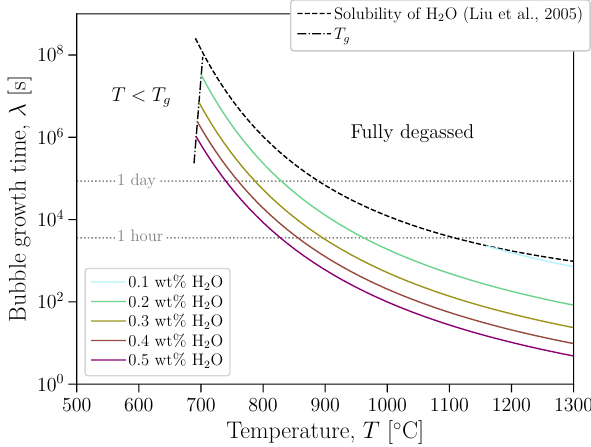
Figure 6: Guide for makers. A quantitative map show- ing how long obsidian should be held at a given tem- perature in order to ensure that all the residual water in the obsidian is removed during the growth of bub- bles. The individual curves are given as examples and represent solutions to the numerical model for bubble growth in obsidian provided by Coumans et al. [2020] for five different typical dissolved water concentrations in the range 0.1–0.5 wt.%. The field T < T —demarked g by the dash-dot curve—represents temperatures below which obsidian will never soften. The dashed curve rep- resents the interconnection of the output value of λ for the temperature at which the initial H O value is at the 2 solubility of H O, meaning that at any temperature be- 2 low that value, bubbles will not form or grow. For ex- ample, see 0.1 wt.% H O which terminates against the 2 dashed curve at around 1150 °C, such that the blue curve is only valid at temperatures greater than 1150 °C. There- fore, for obsidian with 0.1 wt.% H O initially, at tempera- 2 tures lower than 1150 °C, the obsidian can be used with- out this pre-processing step. To define the dashed line for a more closely spaced number of values of initial H O concentrations than given as solid curves here (to 2 define the dashed curve, we use 0.05–0.2 wt.% closely spaced). The dashed curve also shows that this limit is not relevant for initial H O concentrations greater than 2 0.2 wt.% H O, because the solubility temperature is be- 2 low T . g